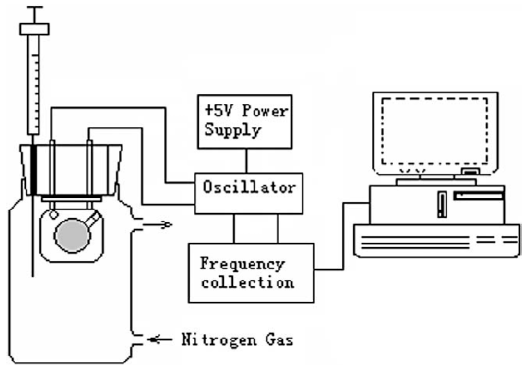
Figure 2. The schematic diagram of the sensor setup [24].